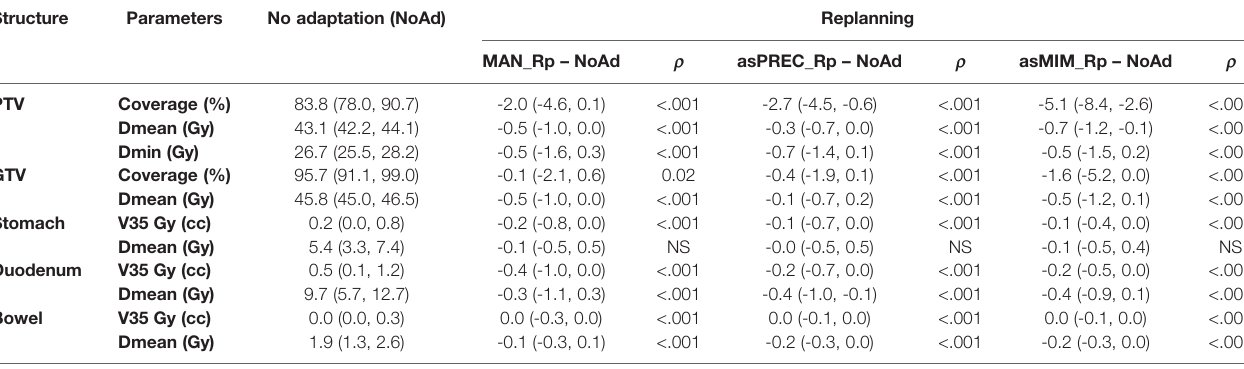
TABLE 2 | Median and interquartile range (Q1, Q3) plan parameters of the replanned doses based on manual (MAN), and autosegmented contours using precision (asPREC) and MIM (asMIM) vs. non-adapted planned doses (NoAd).